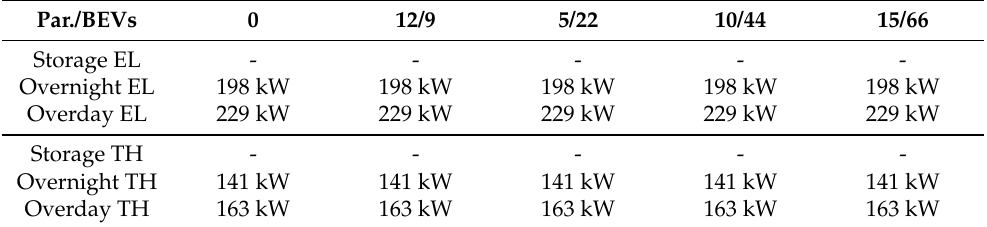
Table 5. Power demand including Electromobility, without Storage Capacities. Par./BEVs